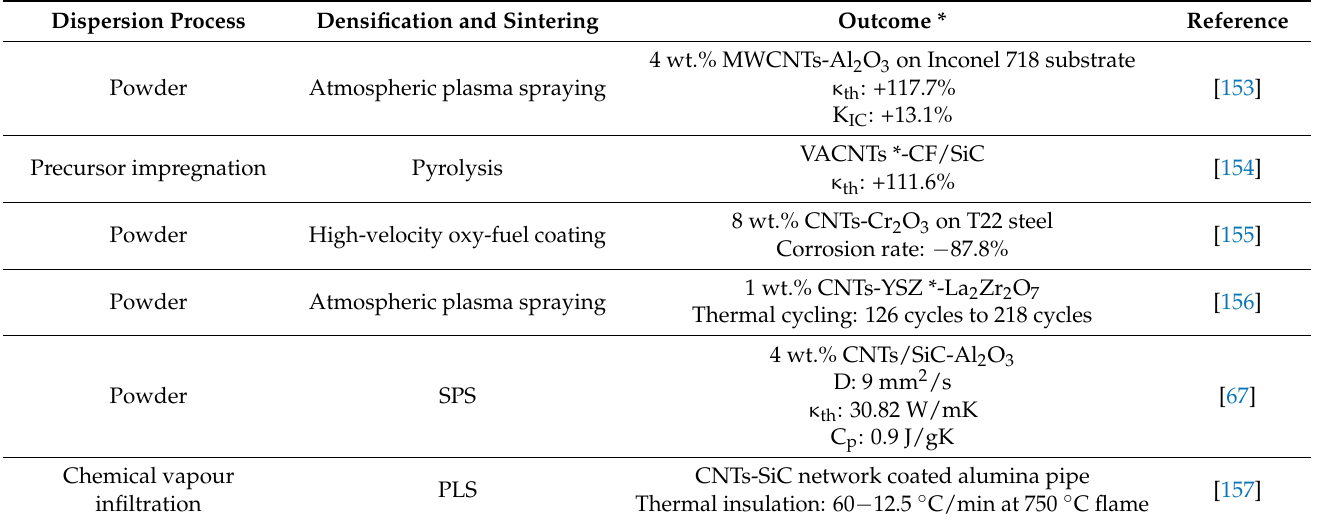
Table 9. Thermal properties of CNTs-CMCs.